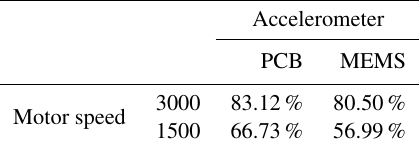
Table 8. Confusion matrix for 1500rpm PCB data and the top three features, classifier trained with ramp-up data.